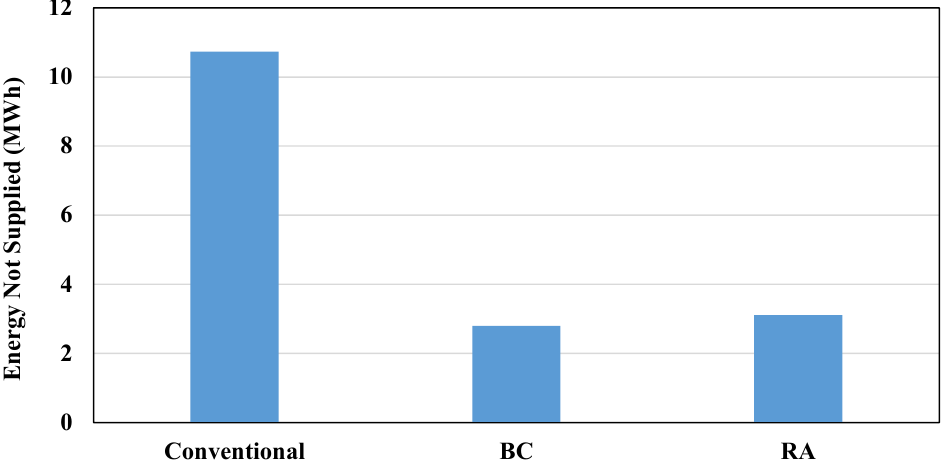
Figure 3. Energy losses in different case studies (on-grid mode).